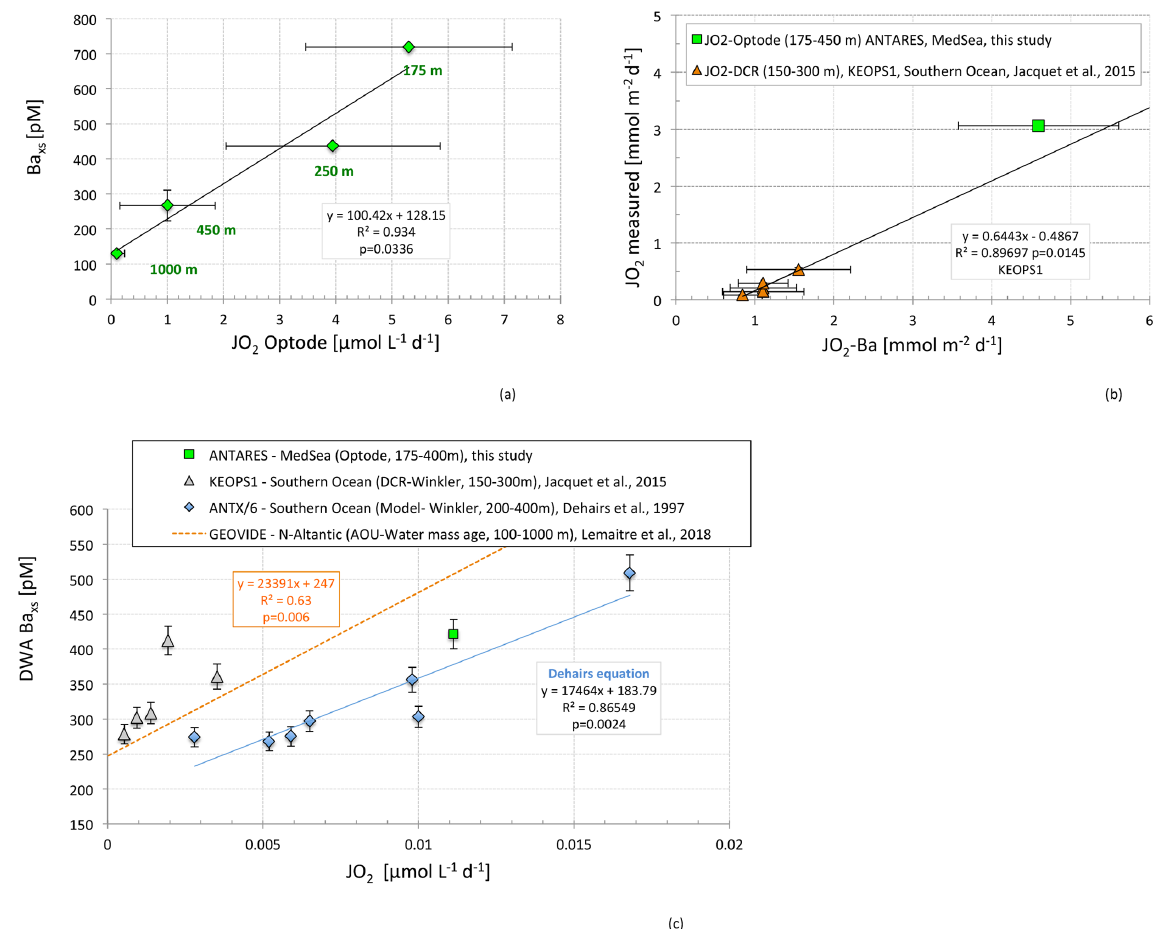
Figure 3. (a) Relationship between Ba xs concentrations (pM) and oxygen consumption rates (µmolL − 1 d − 1 ) from optode measure- ments (JO 2 -Opt) at ANTARES; (b) confrontation of oxygen consumption rates (JO 2 ; mmolm − 2 d − 1 ) obtained from different methods: optode measurements (this study; green square), dark community respiration (DCR) (Winkler titration; red triangles; JO 2 -DCR; Jacquet et al., 2015; KEOPS1) and Dehairs’s transfer function calculation (Dehairs et al., 1997) based on Ba xs contents. The black line corre- sponds to the correlation obtained during KEOPS1 (Jacquet et al., 2015); (c) Dehairs’s relationship between depth-weighted average (DWA) mesopelagic Ba xs (pM) and JO 2 (µmolL − 1 d − 1 ) compared to the ANTARES result (this study), KEOPS1 data (Southern Ocean; Jacquet